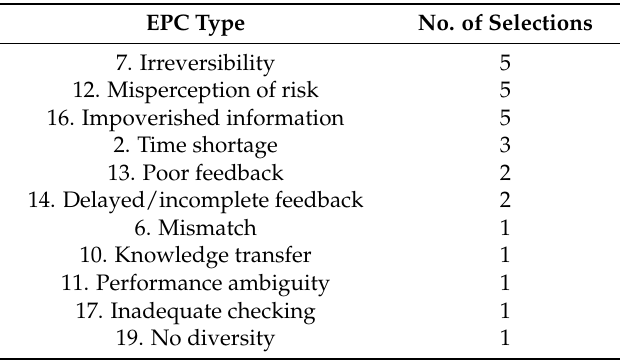
Table 5. Ranking of the selected